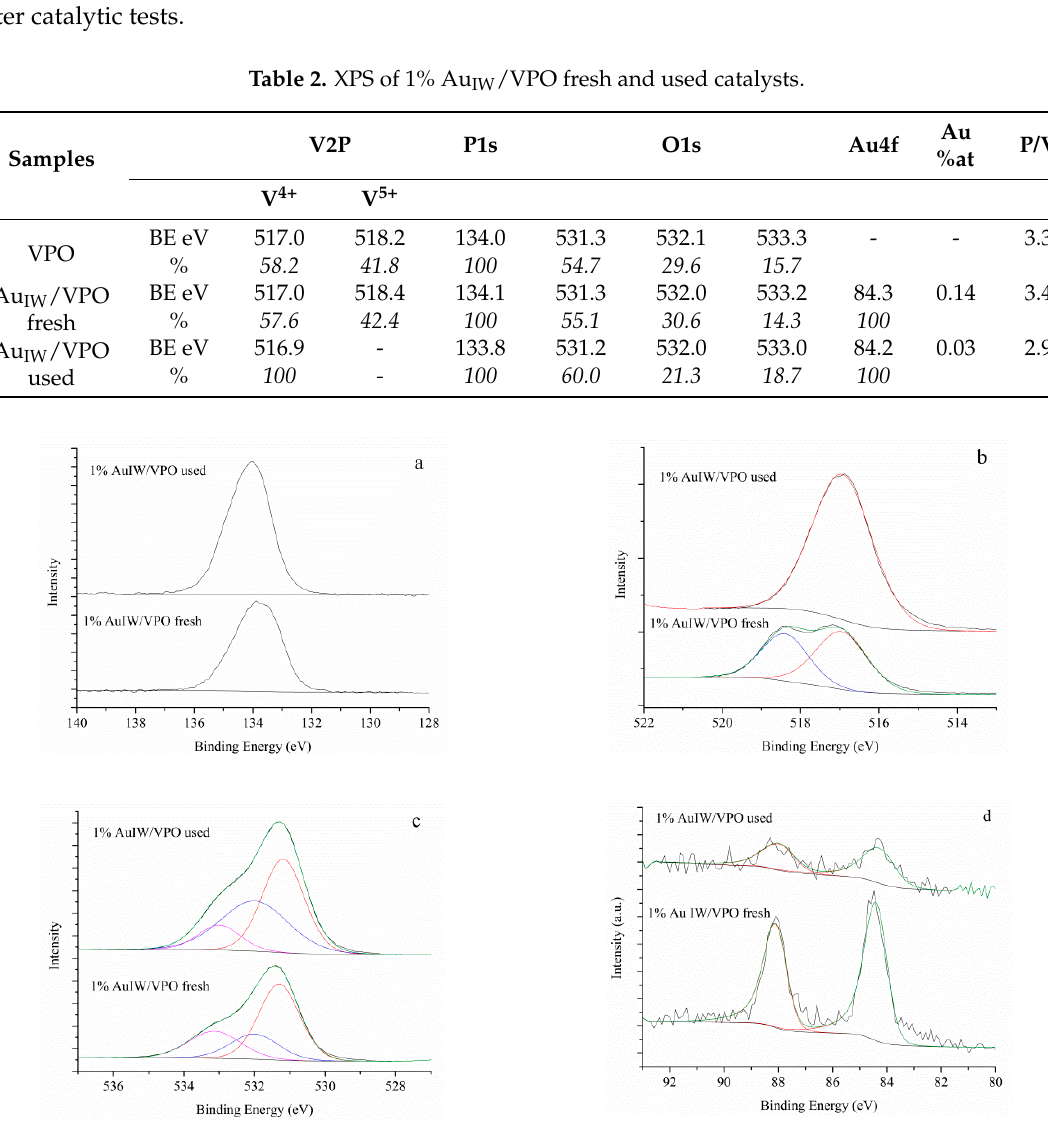
Table 2. XPS of 1% Au IW /VPO fresh and used catalysts.